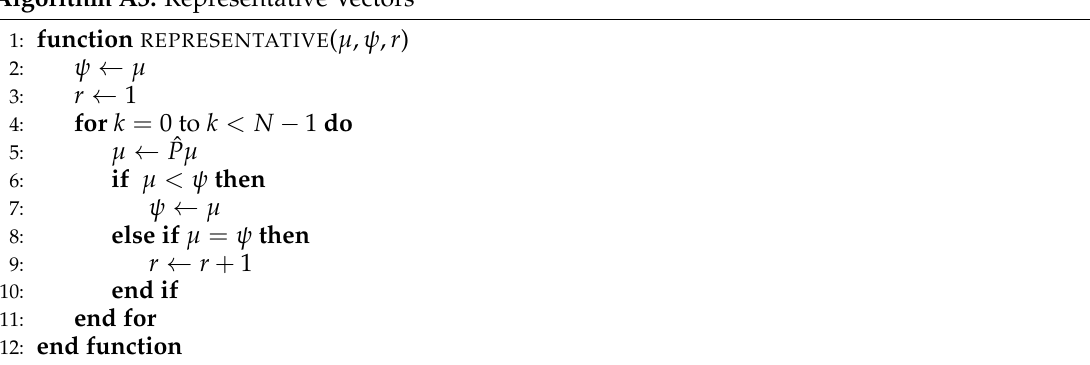
Algorithm A3. Representative